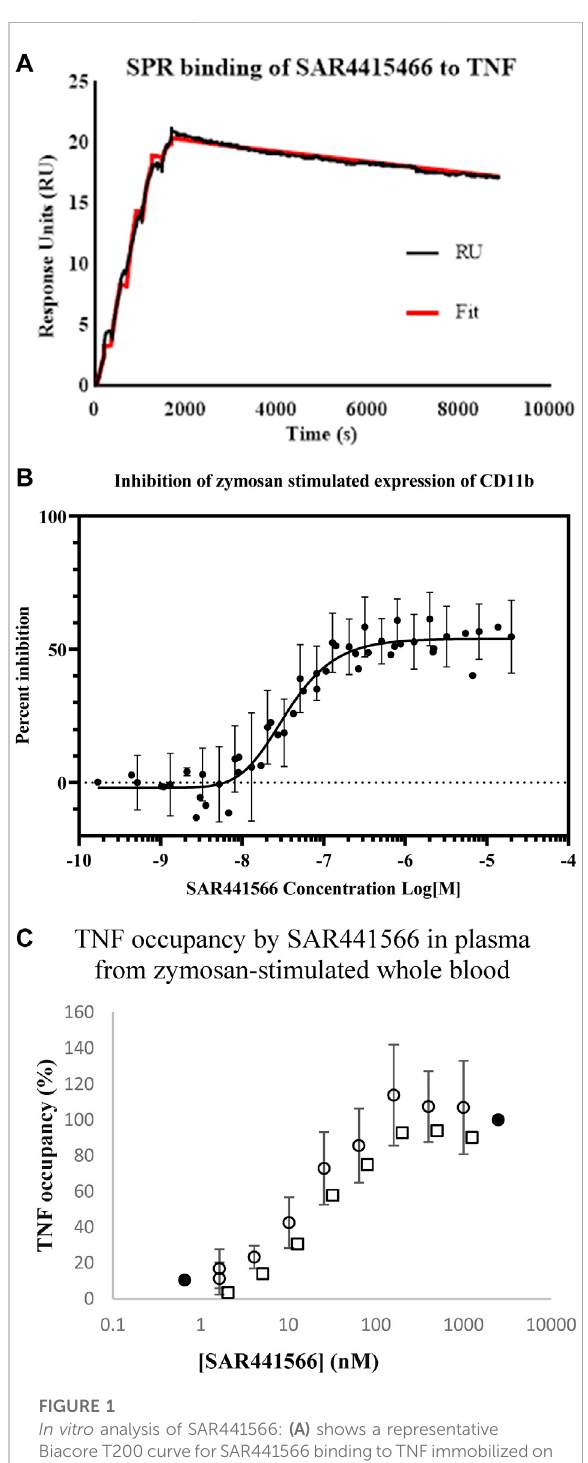
FIGURE 1 In vitro analysis of SAR441566: (A) shows a representative BiacoreT200curveforSAR441566bindingtoTNFimmobilizedon a CM5 sensor chip. The KD was determined to be 15.1 nM (n = 4) (Table 1). (B) inhibition of zymosan stimulated expression of CD11b on granulocytes in human whole blood by total (free and protein bound) SAR441566 with an IC50 of 35 nM (n = 50) (Supplementary Figures S1A,B show a representative CD11b inhibition curve and corresponding fl ow cytometry analysis. (A) TNF occupancy in plasma samples from zymosan-stimulated